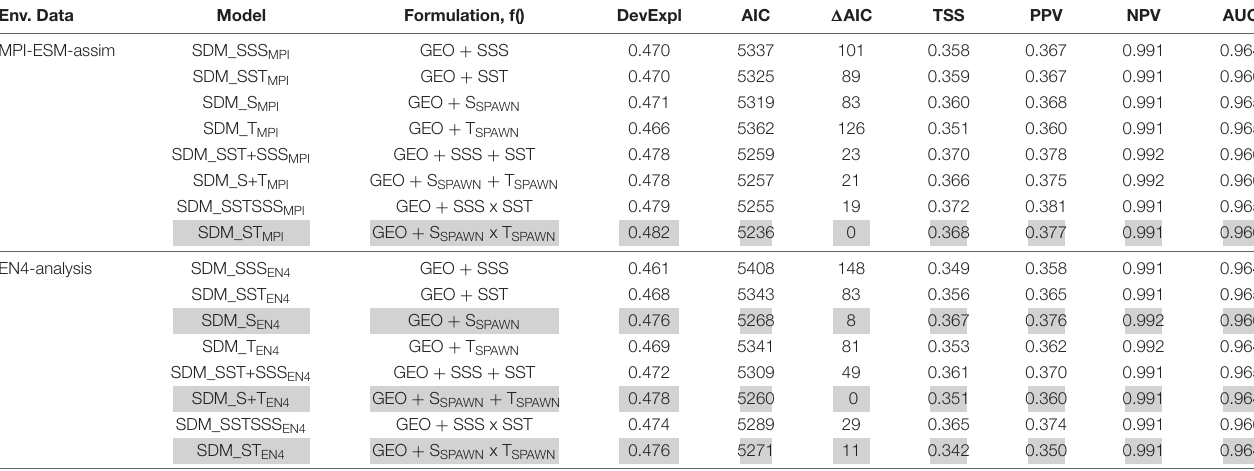
TABLE 3 | Model fitting results for species distribution models (SDM) calibrated with different environmental reference data (Env. Data). Env. Data